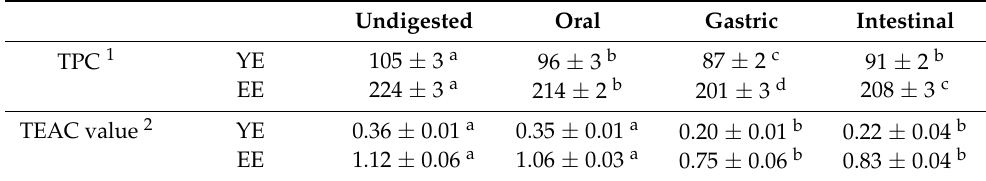
Table 3. Total phenolic content (TPC) and antioxidant activity (TEAC value) of yarrow ultrasound- assisted extract (YE) and yarrow enriched-extract (EE) after oral, gastric, and intestinal digestion. Undigested Oral Gastric Intestinal TPC 1 YE 105 ± 3